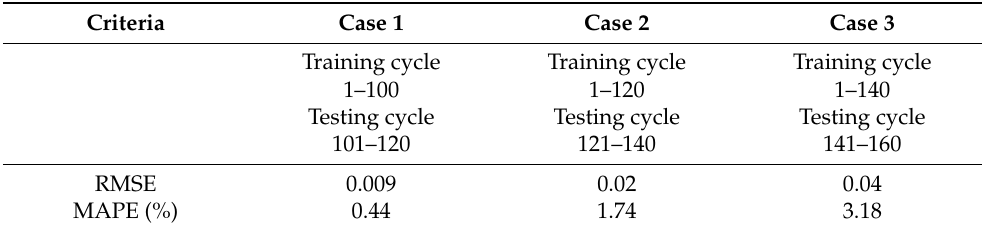
Table 2. Prediction performance of battery No 7 for three separate cases.